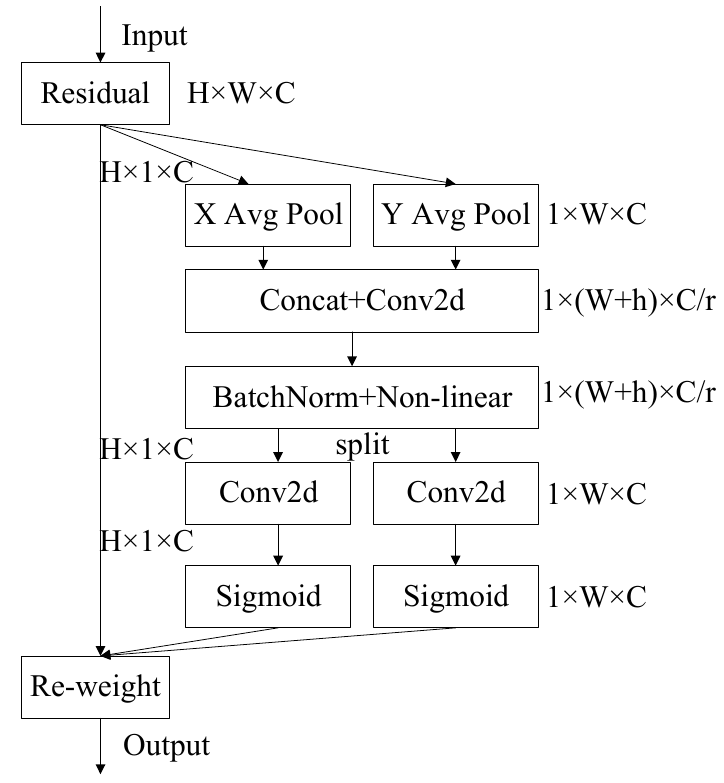
Figure 9. CA module structure.